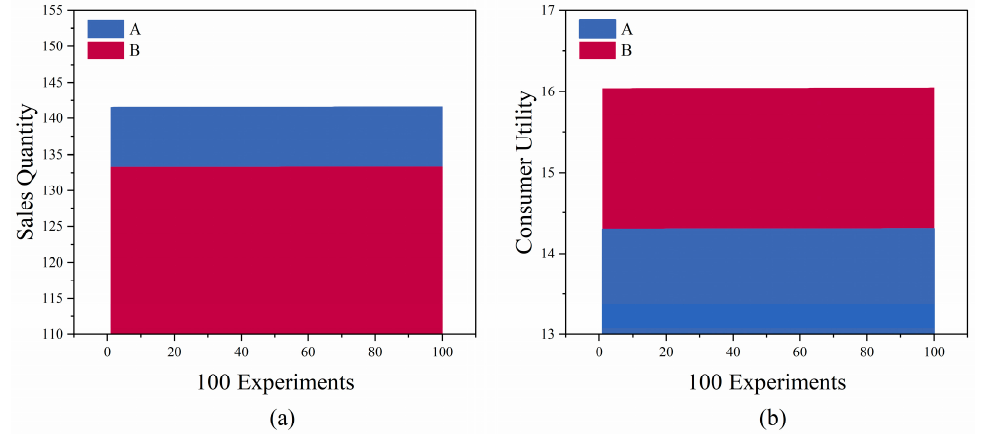
Figure 7. ( a ) Sales quantity in A and B; ( b ) consumer utility in A and B. ( t = 100).